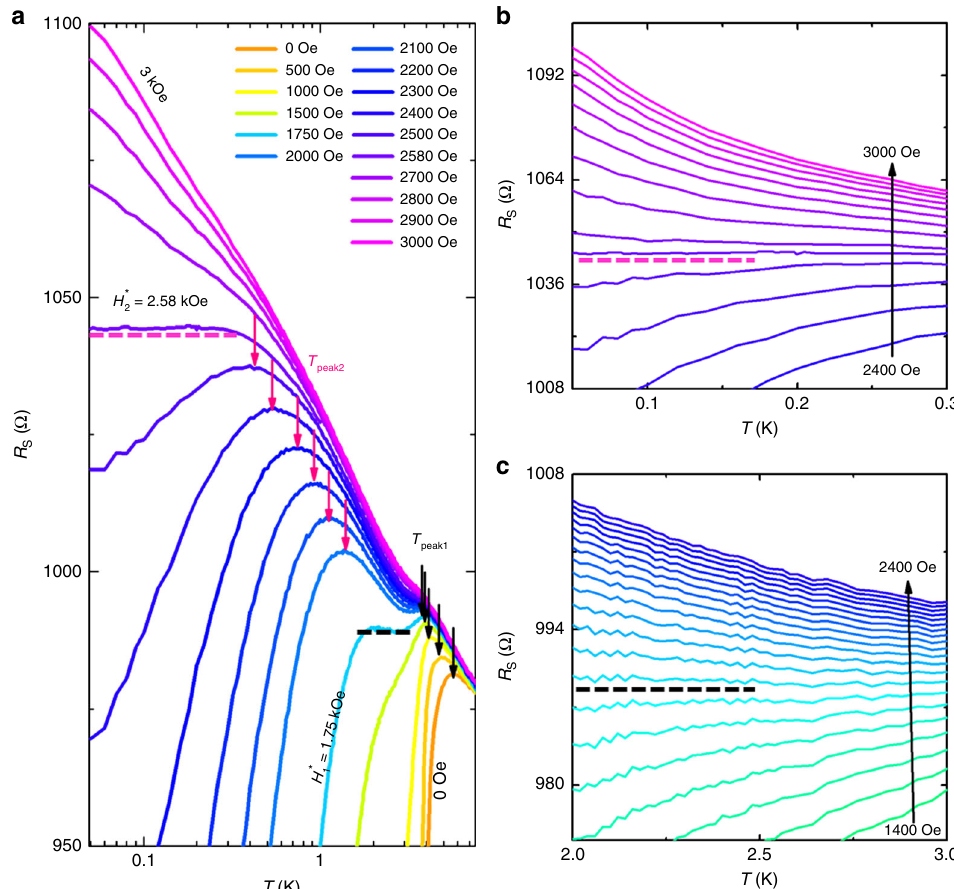
Fig. 3 Two QPTs observed in graphene – tin nanoislands array. a The sheet resistance R s as a function of temperature T for different magnetic fi elds H from 0 to 3 kOe. The black and pink arrows indicate the R s peaks. b , c The detailed data collected from the low temperature region (0.05~0.30 K) and high temperature region (2.0~3.0 K) with the magnetic fi elds varying from 2.4 to 3 kOe and from 1.4 to 2.4 kOe, respectively. The black and pink dashed lines indicate the critical fi elds H 1 * = 1.75 kOe and H 2 * = 2.58 kOe, respectively, where the R s values are independent of the